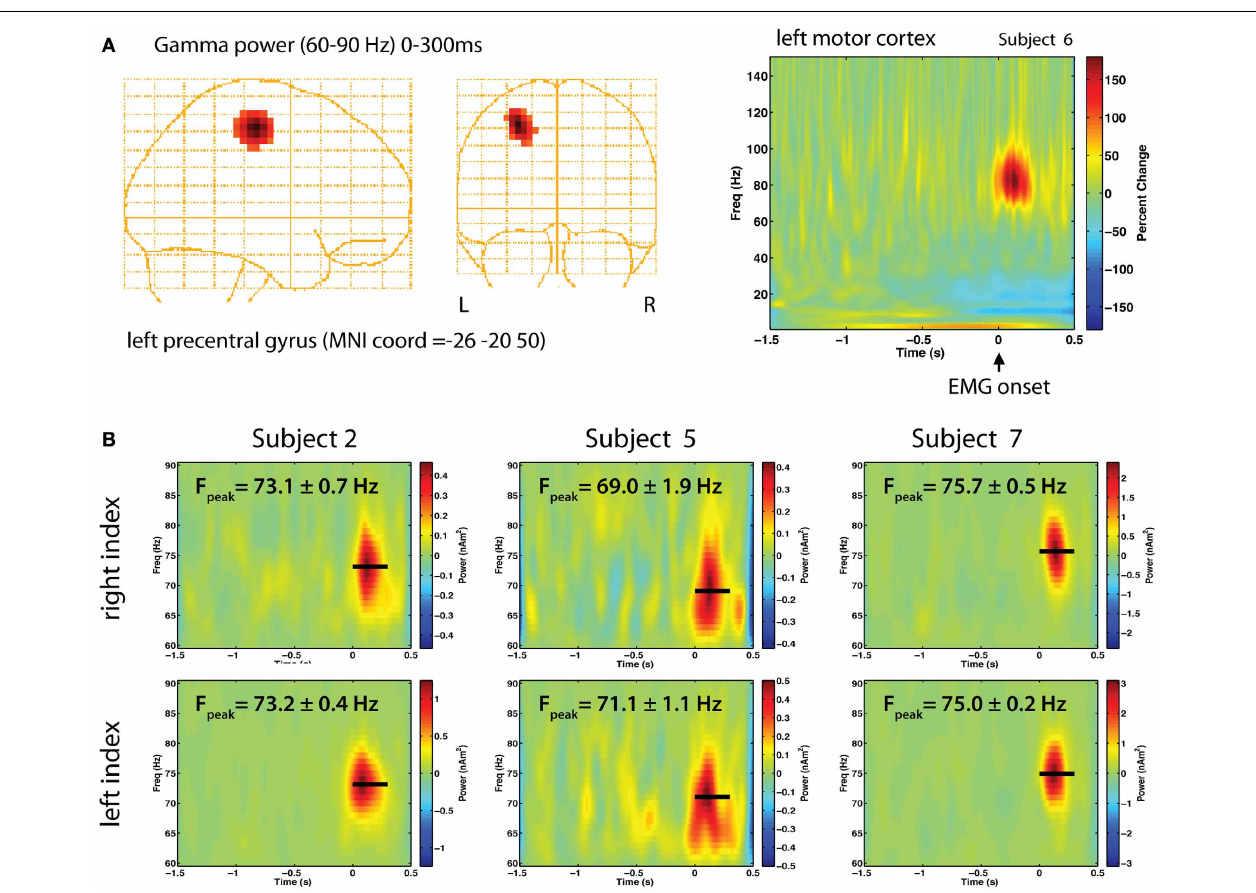
FIGURE 1 | (A) Gamma band responses during right finger abductions in a right-handed subject. Synthetic Aperture Magnetometry (SAM) source localization was used to localize the generator of gamma power in right motor cortex, transformed to MNI coordinates with 4mm resolution (left). A time-frequency plot of the source activity (right) over the range of 1–150Hz shows a brief burst of gamma band activity around 80Hz immediately following EMG onset ( t = 0s) as a percent change above baseline